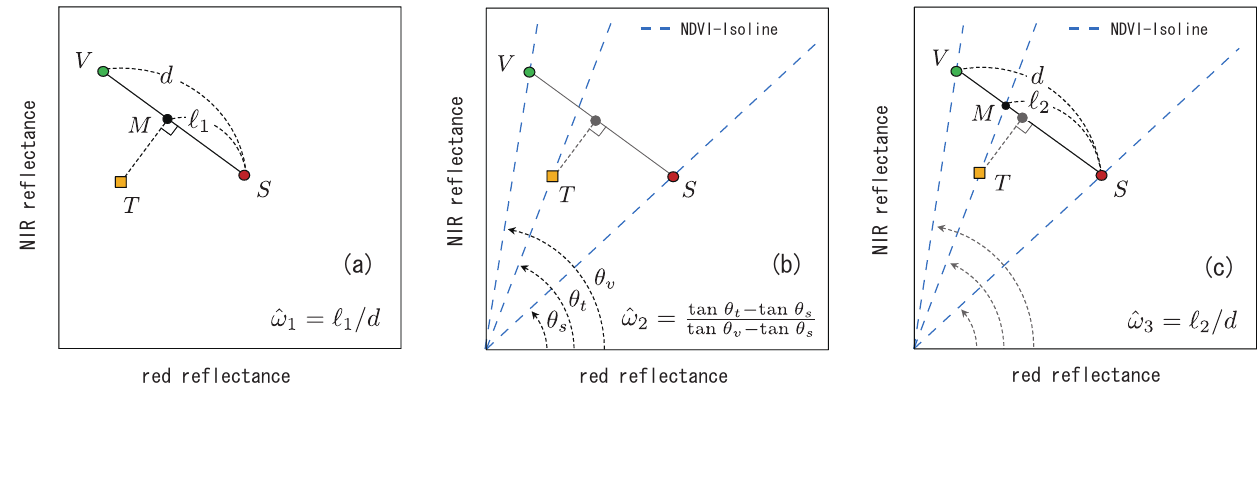
Figure 1 . Illustration of the three algorithms in red-NIR reflectance space. (a) Reflectance based LMM, (b) VI based LMM (for the case of NDVI), and (c) VI-Isoline based LMM (also for the case of NDVI). The marks denoted by V and S represent endmember spectrum of vegetation and non-vegetation surfaces, respectively. T and M represent measured and modeled spectrum, respectively. The key variables (such as d , ℓ determine FVC estimation are also shown in the